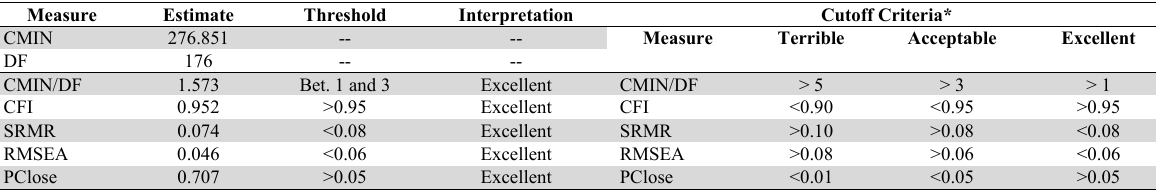
Fit Measures and Cutoff